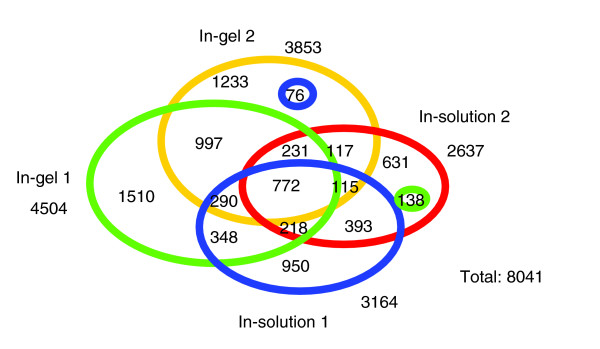
Diagram of peptides found in multiple datasets. All overlaps of peptides are shown (two way, three way, and four way) for all four input datasets: in-gel 1 (green), in-gel 2 (yellow), in-solution 1 (blue), and in-solution 2 (red). Numbers represent the number of shared peptides in the respective overlapping areas.